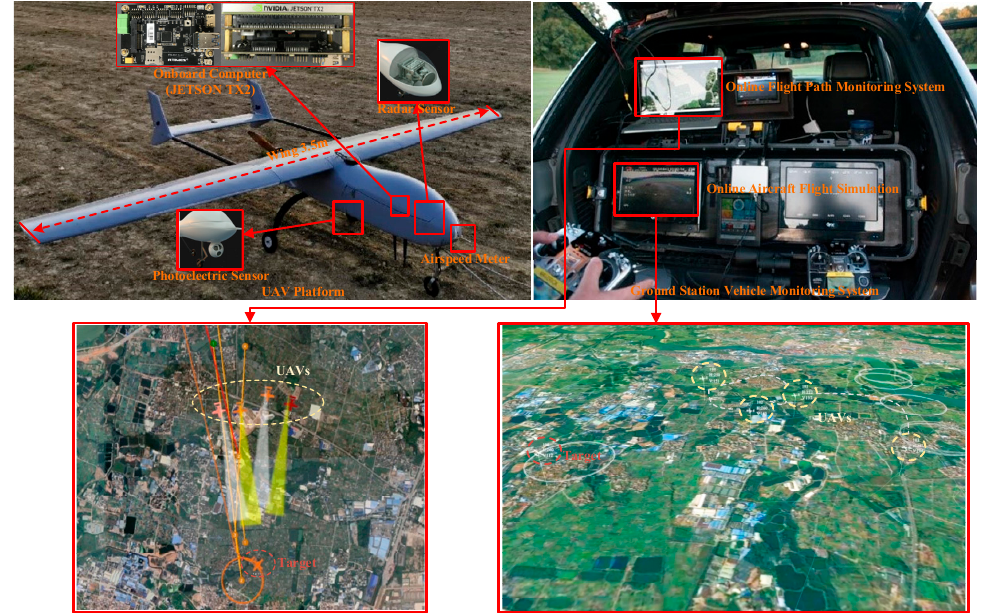
Figure 7. Composition of flight test system.